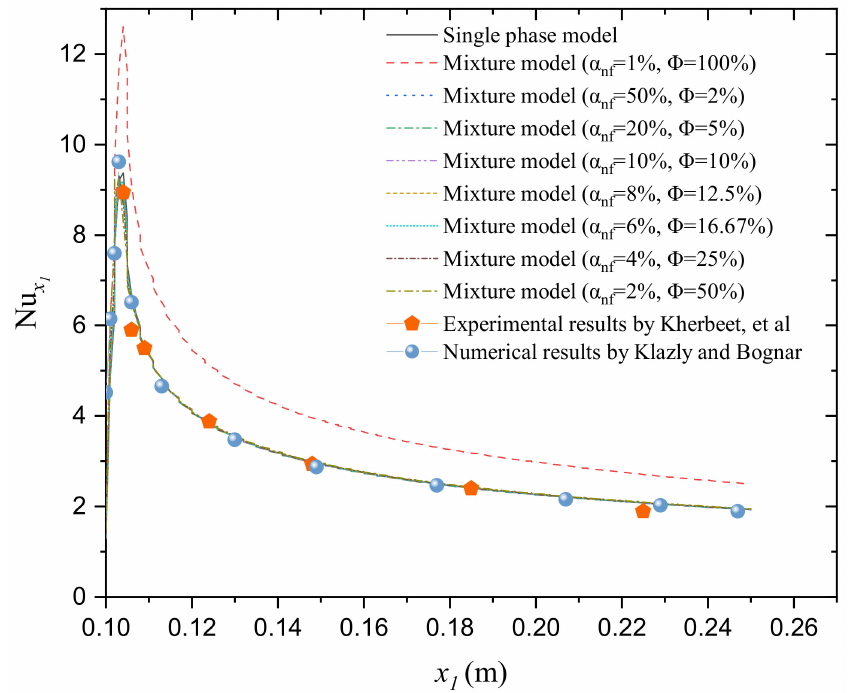
Figure 16. Local Nusselt number along the heated bottom wall of a microscale backward-facing step at Re =